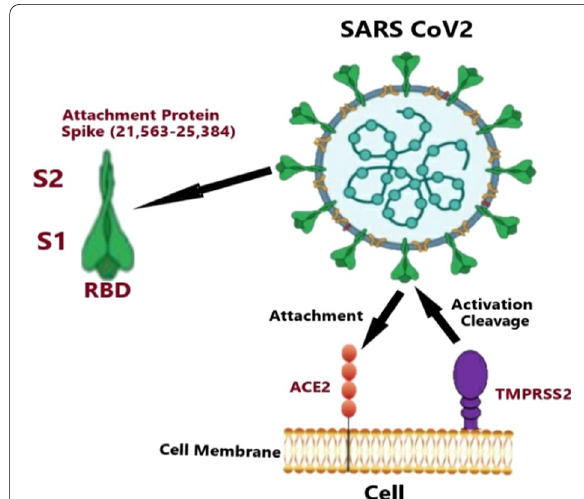
Fig. 1 SARS-CoV-2 cellular entry. The binding between the S-protein trimer of SARS-CoV-2 and ACE2 receptor. The figure demonstrated the receptor-binding domain (RBD) of the S1 subunit and the hydrophobic fusion peptide of the S2 subunit where the S-protein is bound to ACE2 and primed with the cellular protease TMPRSS2, and the fusion S2 subunit undergoes a conformational rearrangement. The affinity between ACE2 and the RBD of SARS-CoV-2 is higher than its affinity with the RBD of the SARS virus